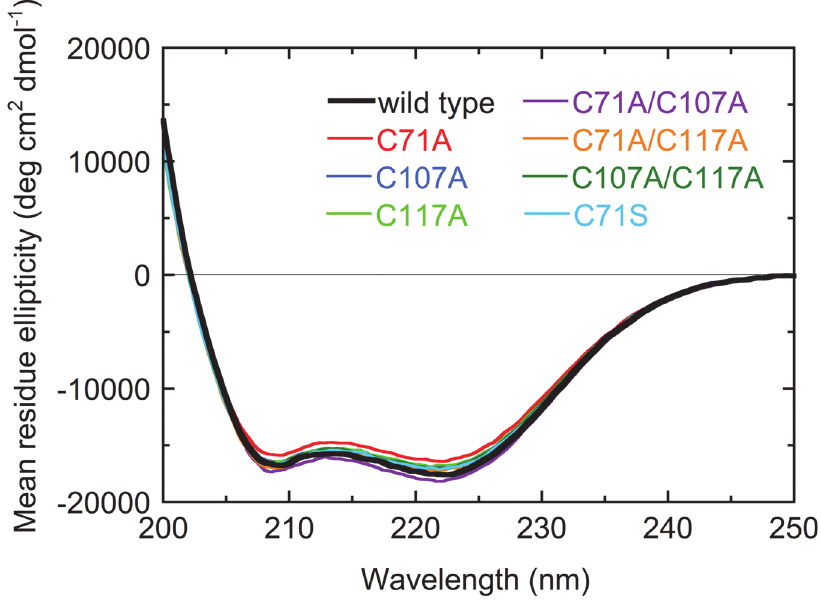
Fig 4. Far-ultra violet (UV) circular dichroism (CD) spectra of the wild type and mutant ADs.